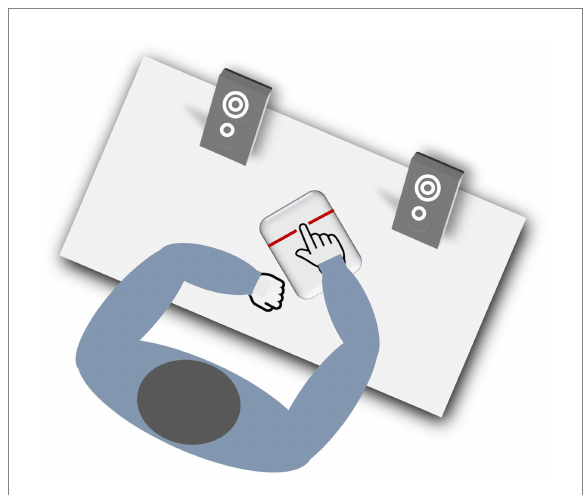
FIGURE 2 Experimental setup. The participants were seated at a table with standard speakers placed about 50 cm in front of them. Tap- onsets of the right index finger disrupted a photo-electric barrier mounted on a board (Elekta Neuromag ® , Helsinki, Finland). Timing of tone presentation as well as registration of tap onsets were realized by E-Prime 3 (Psychology Software Tools Inc., Sharpsburg, PA, United